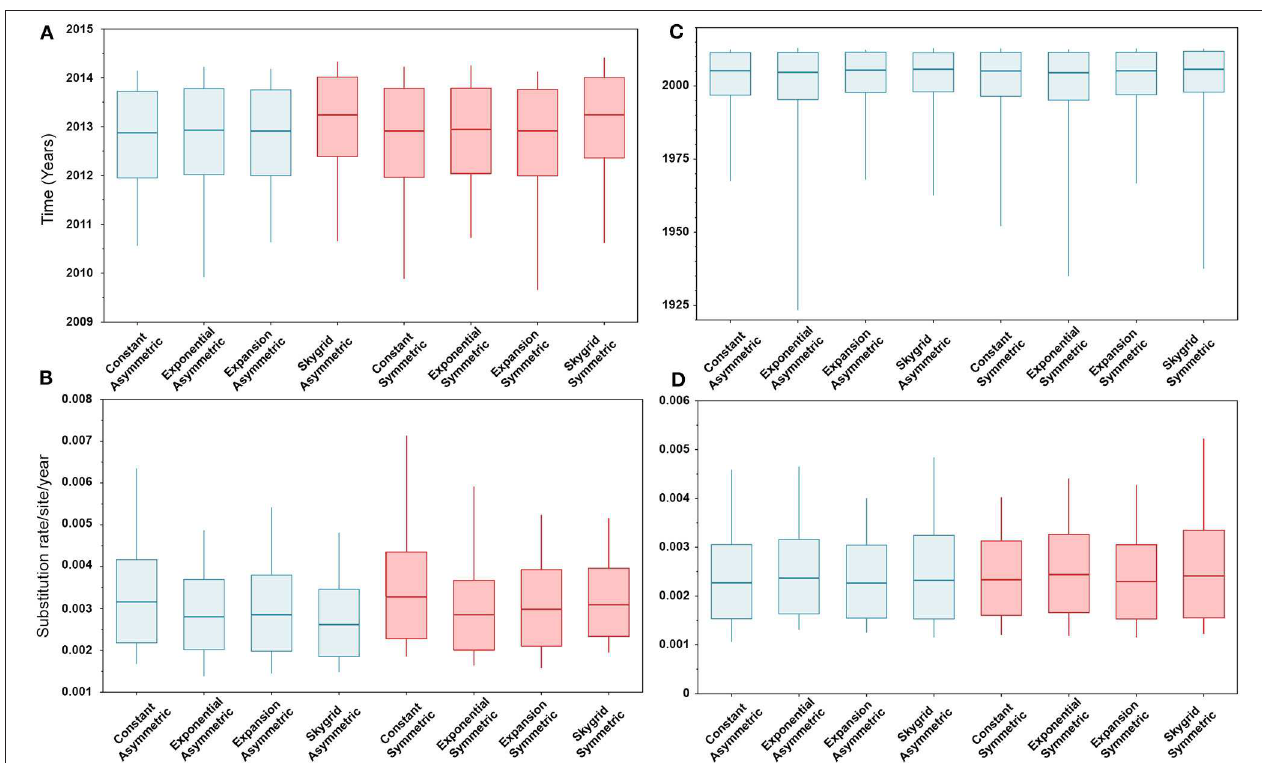
FIGURE 2 | Box plots of divergence times and evolutionary rates (substitution rate/site/year) of hemagglutinin (HA) and polymerase basic 2 (PB2) gene segments of human-like H3 swine influenza virus collected between January 2015 and June 2018 in the United States. The boxplots summarize the posterior estimates of eight phylodynamic model combinations (node-age and BSSVS priors) for each gene segment. Boxes represent 95% high posterior density (HPD), and midlines indicate the posterior median for each estimate. Blue and red boxes indicate symmetric and asymmetric models, respectively. (A) Divergence times of HA gene. (B) Substitution rates/site/year of HA gene. (C) Divergence times of PB2 gene. (D) Substitution rates/site/year of PB2